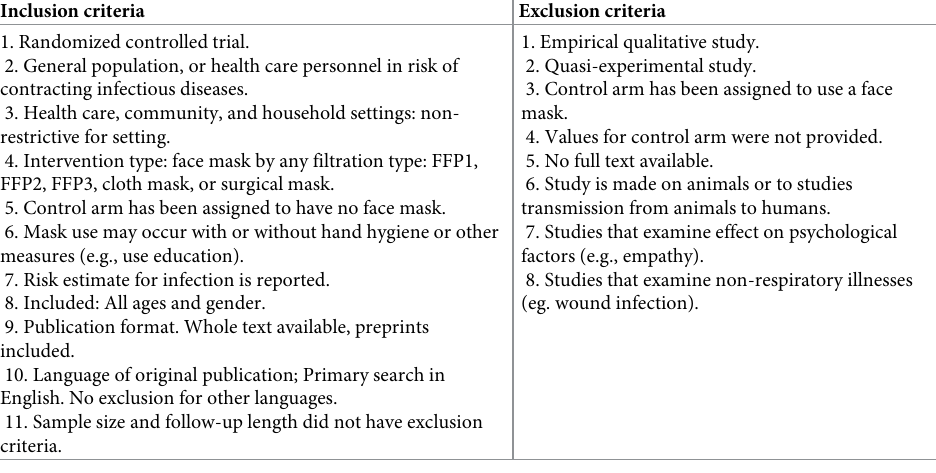
Table 2. Inclusion and exclusion